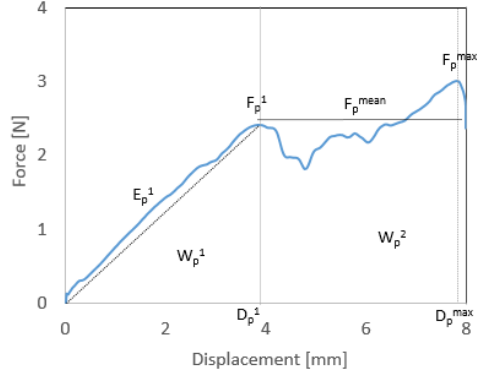
Figure 3. Force/displacement curve obtained from puncture test on fruit flesh and extracted parameters.